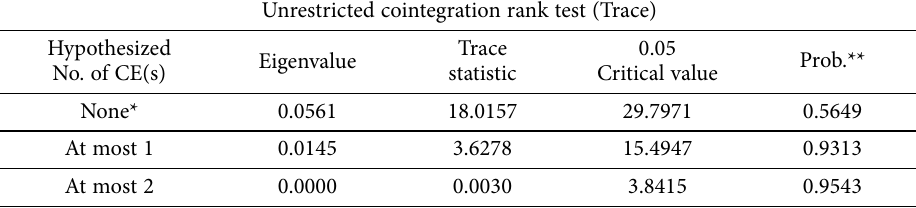
Table 5. Cointegration condition for LKSE, LWPI & LCOP Unrestricted cointegration rank test